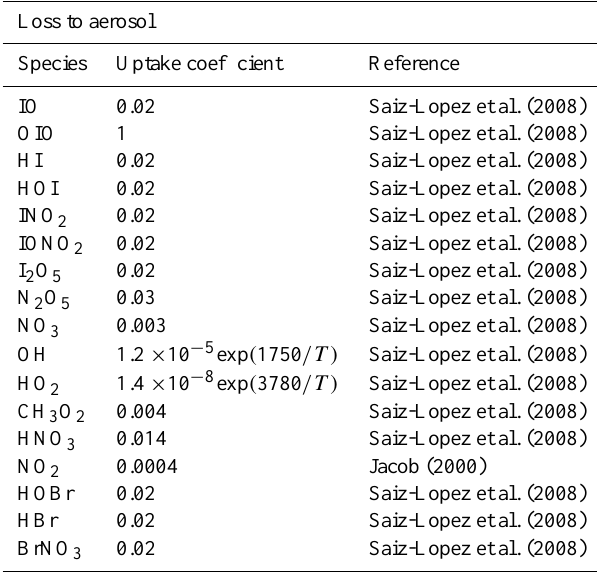
Table A4. Halogen chemistry reaction scheme – photochemical reactions. Citation refers to recommended absorption cross section and quantum yield.